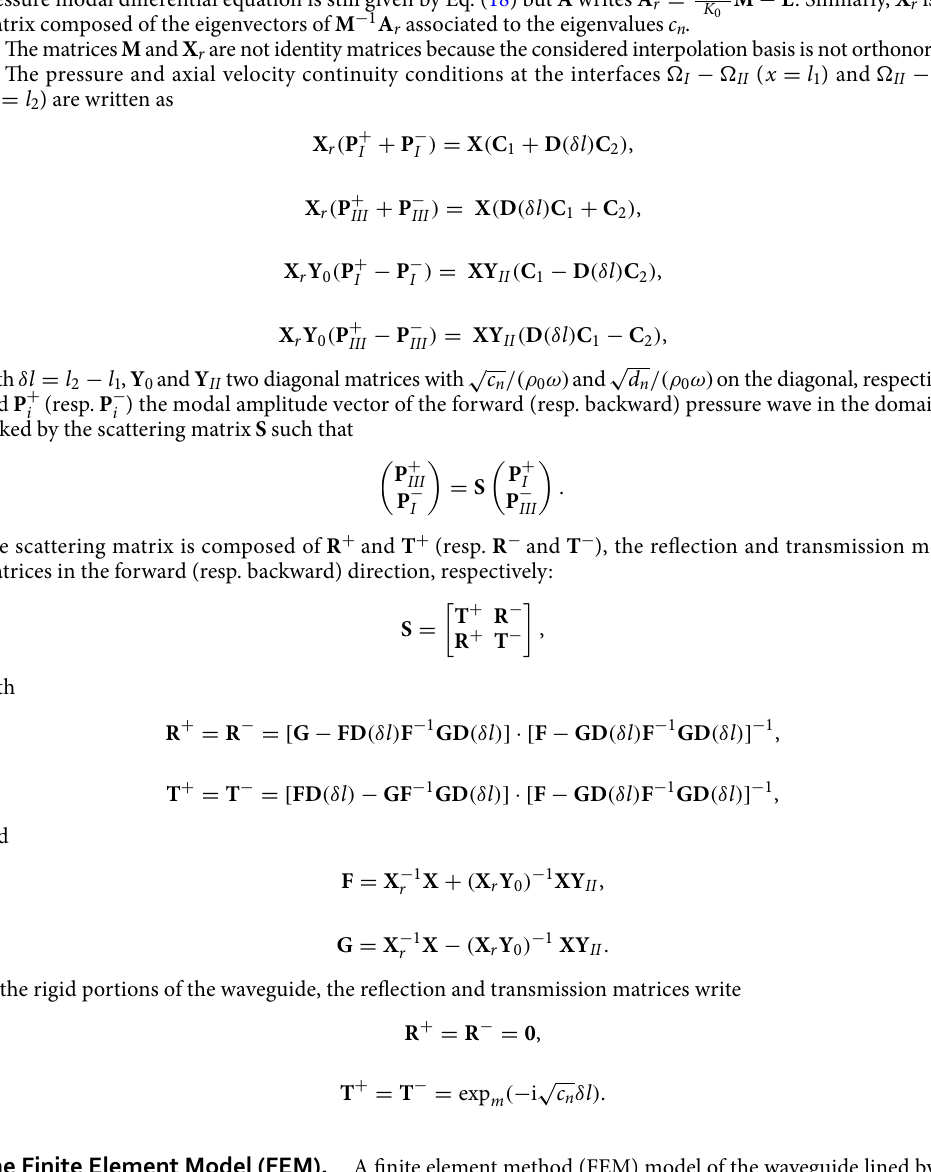
algorithm 31 implemented in the Matlab function fminsearch and the metaheuristic Particle Swarm Optimization (PSO) algorithm 32 coded by Heris in Matlab language 33 . The PSO algorithm is an intelligent optimization algo- rithm well suited for optimization problems with large number of variables and possessing many local minima. The NM algorithm has a shorter execution time because it requires a lower number of evaluations of the cost function than the PSO algorithm. However, it is more likely to reach a local minimum especially if the number of variables of the problem is large and/or if it is initialized with a poor initial guess. 20 dB or for maximal α + ( f 0 ) are performed using the NM The optimizations of a single HR for TL ( f 0 ) = algorithm and the TMM predictive model. The designed FMAA for wide duct is obtained in two steps.